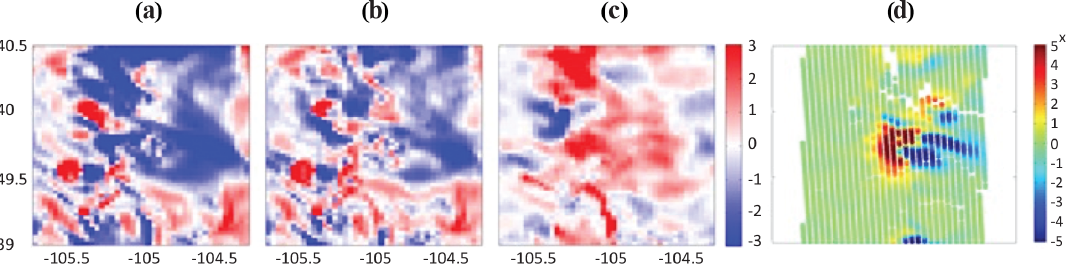
wind states as well because the NO 2 spread results from the wind differences among ensemble